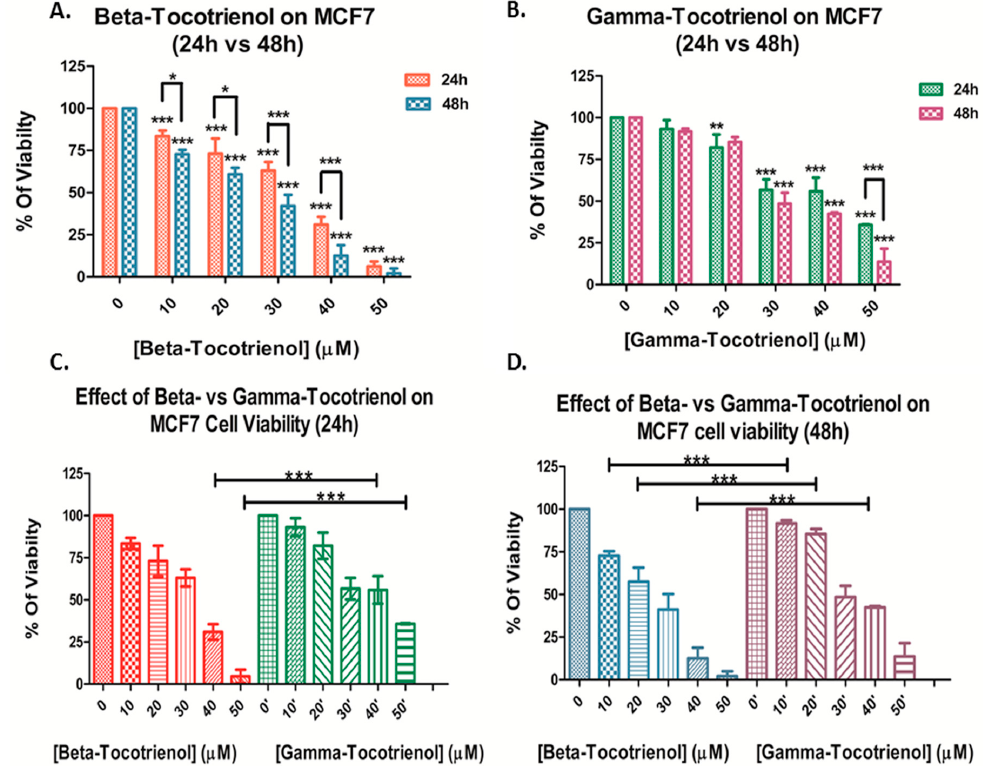
Figure 2. Proliferation of MCF-7 cells after 24 and 48 h of treatment with various concentrations of beta-( A ) and gamma-( B ) tocotrienols (0–50 μ M). Significance between both treatments was tested 232 after 24 h ( C ) and 48 h ( D ). *, ** and *** indicate p < 0.05, p < 0.001 and p < 0.0001 respectively. 233 Table 1. Summary of IC50 values upon treatment of breast cancer cells MDA-MB-231 and MCF7 with a range of concentration (0-50 µ M) of beta- or gamma-tocotrienols for 24 and 48 h.